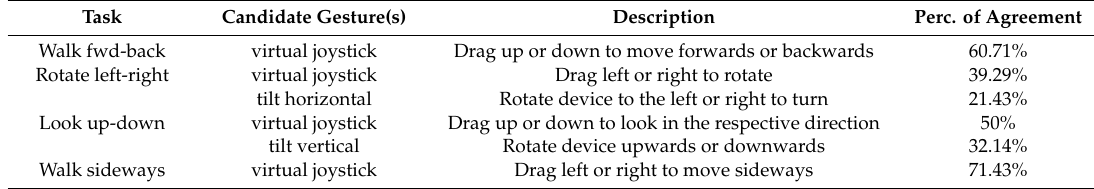
Table 2. The candidate gestures for each of the four